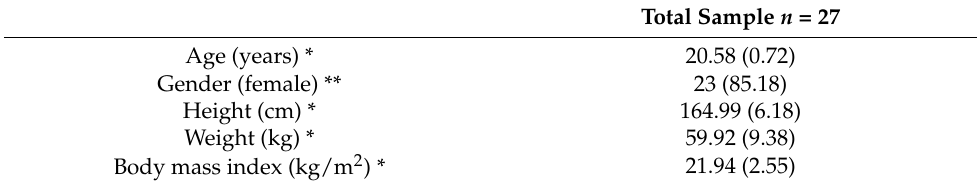
Table 1. Descriptive statistics in sample.